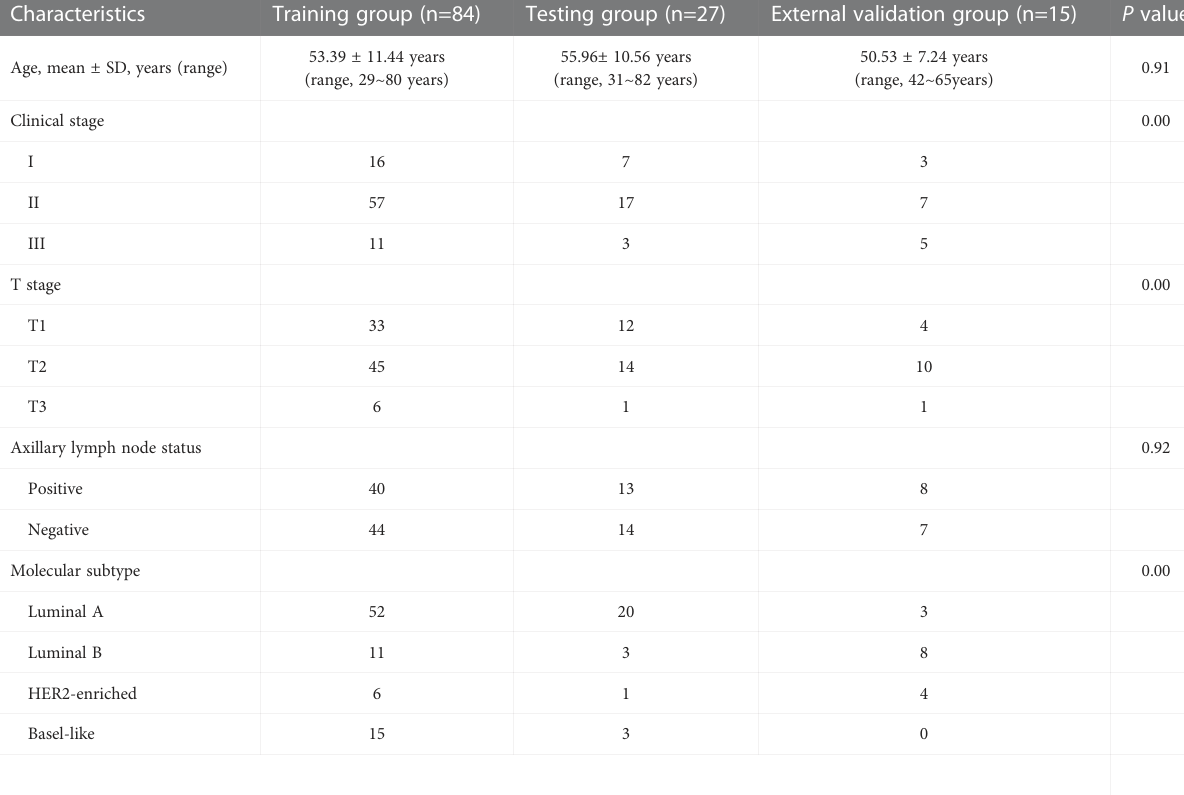
TABLE 1 The clinical characteristics of patients in the training, testing and external validation groups.